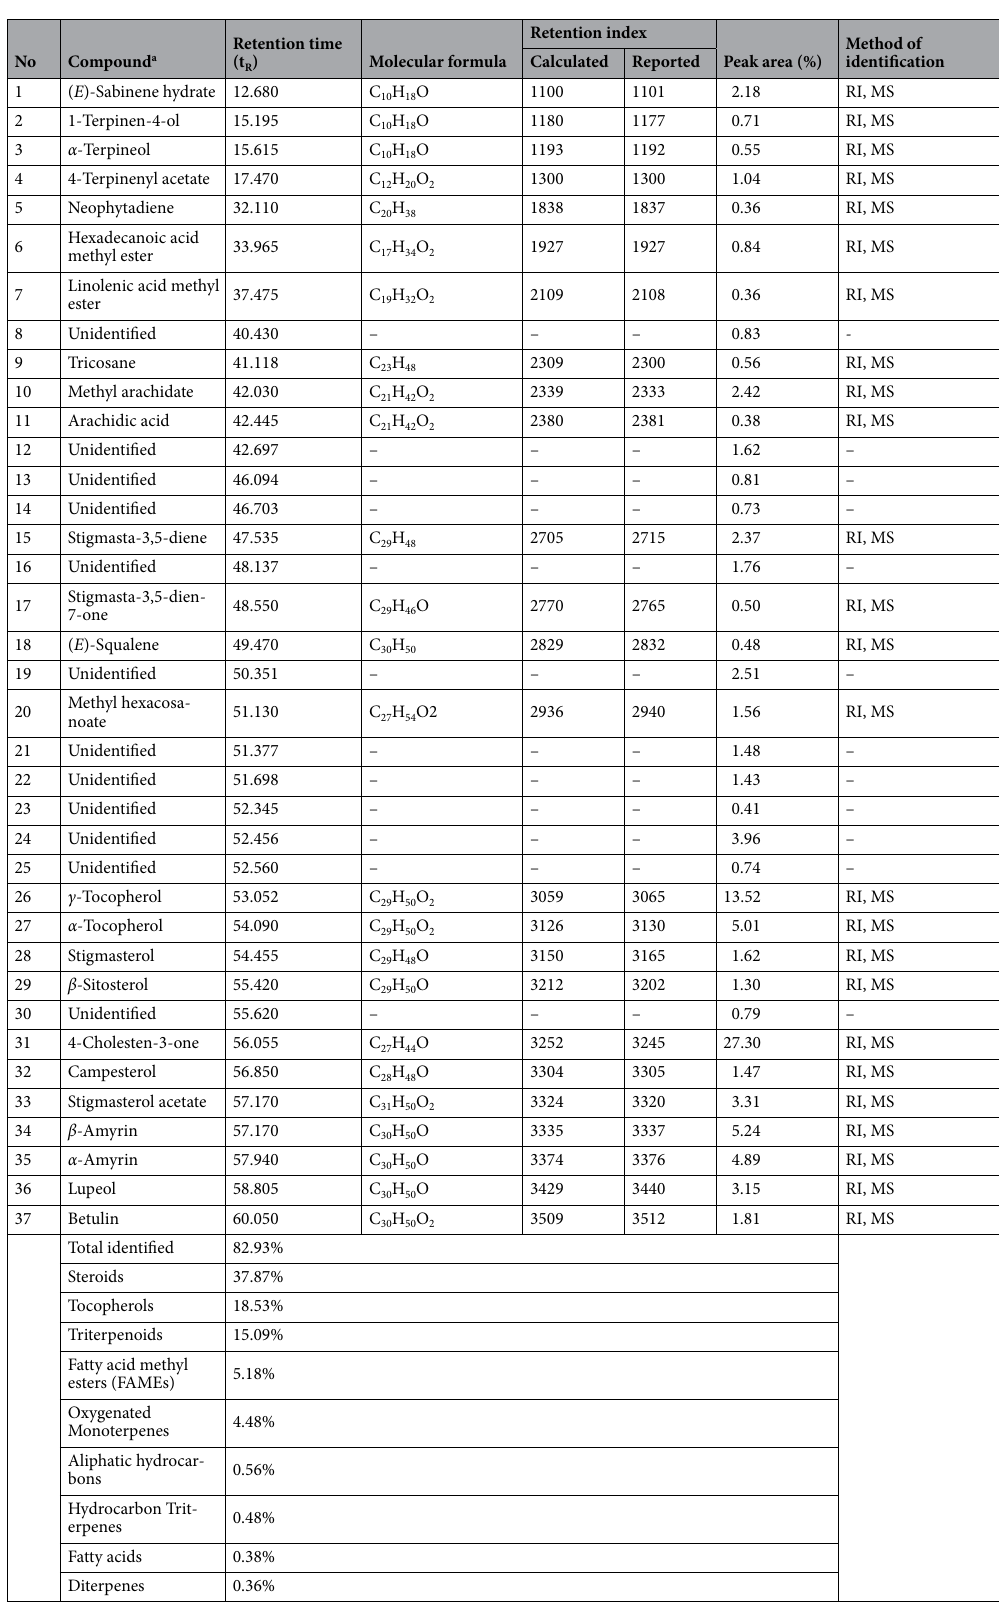
Table 1. Chemical composition (%) of n -hexane extract of O. vulgare leaves grown in Egypt. a Compounds are arranged according to their elution. RI: Kovats retention index on DB-5 column. RI, identification of metabolites was based on the comparison of reported Kovats retention indices with the measured ones. MS, identification based on mass spectral data and fragmentation